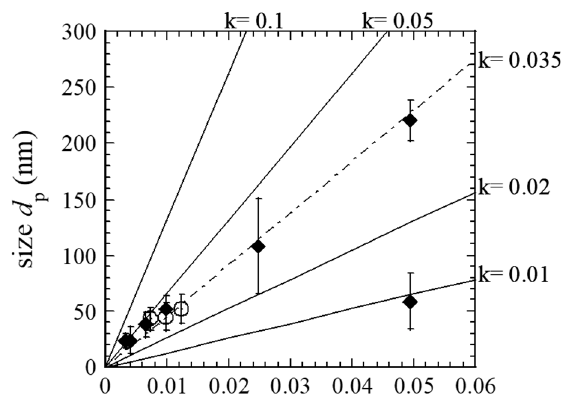
Figure 9. Dependence of d p on τ res . Open circles indicate the results reported earlier [23]. Lines were obtained by Equation (4). Error bar shows the standard deviation.